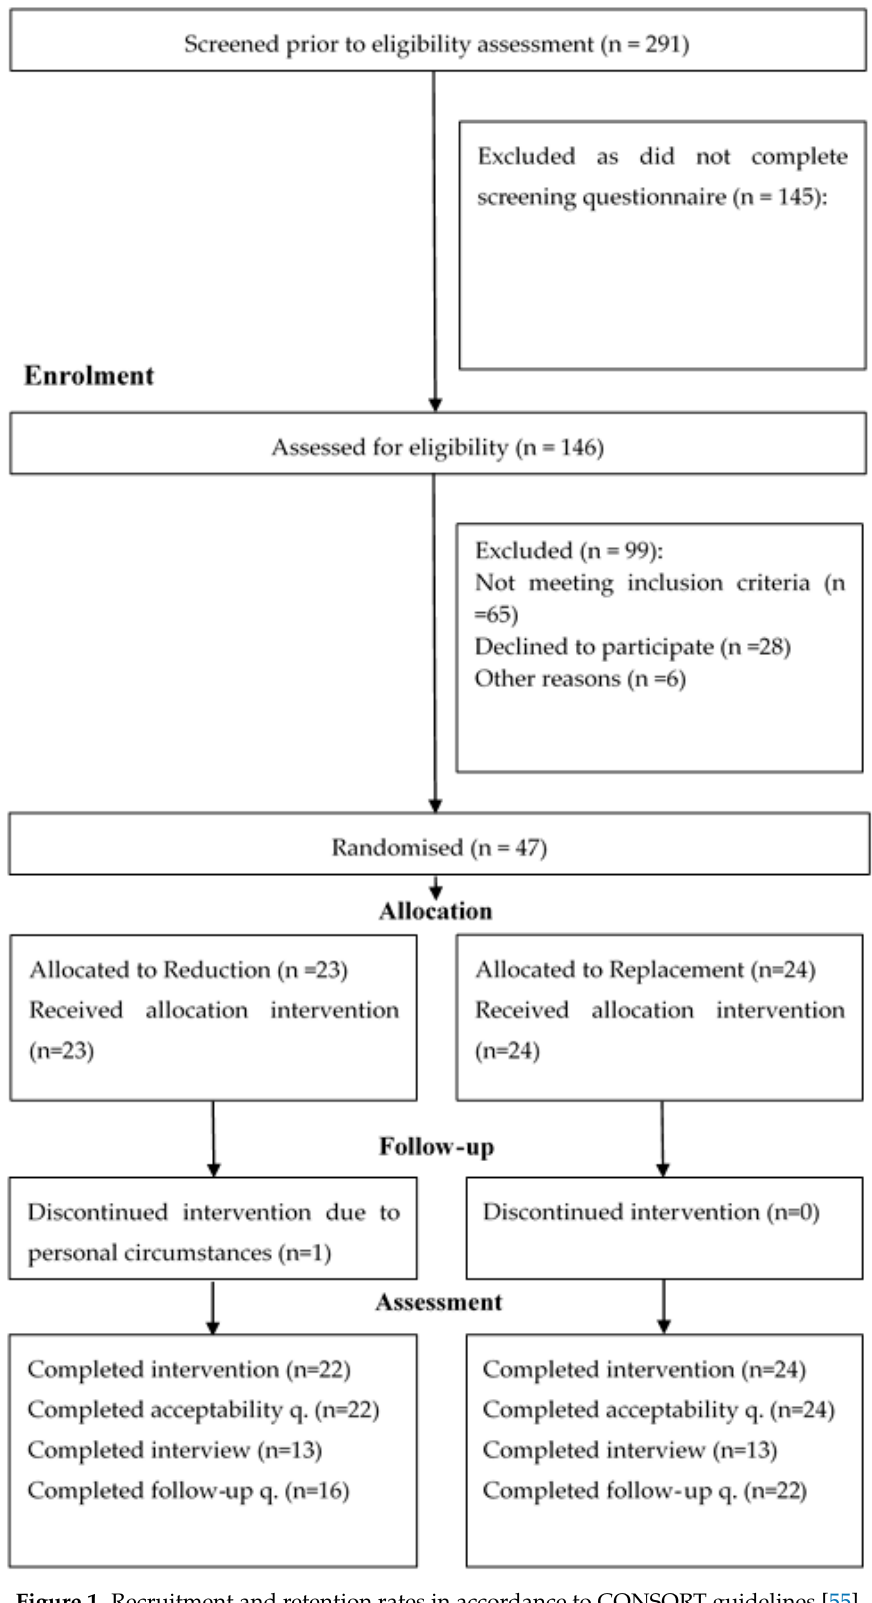
Figure 1. Recruitment and retention rates in accordance to CONSORT guidelines [55].